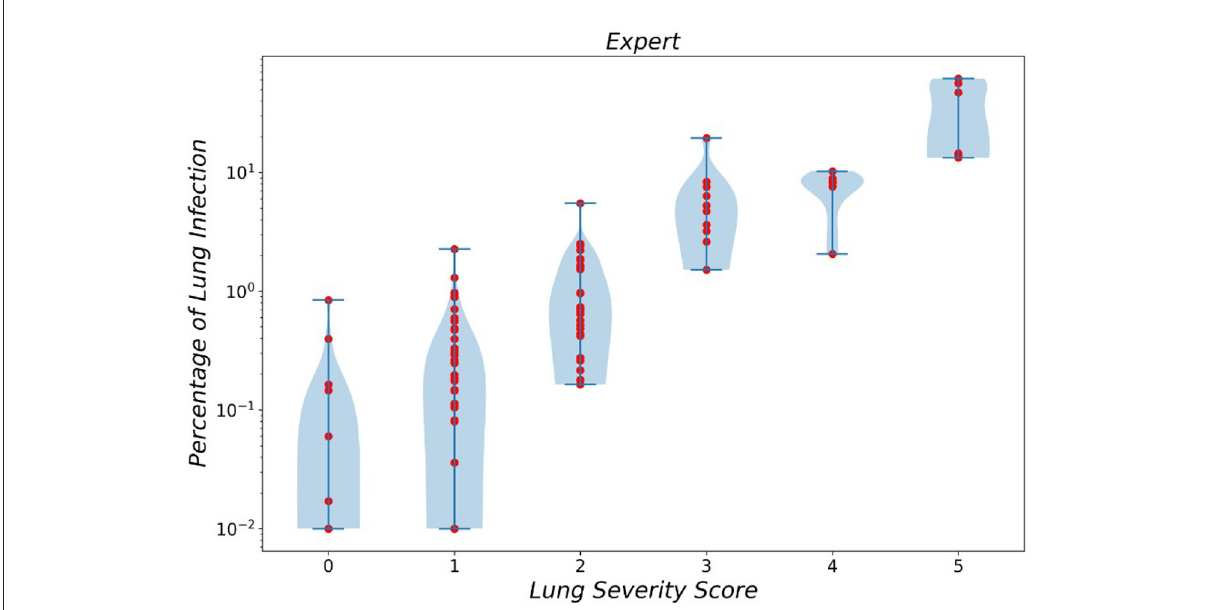
FIGURE6 Violin plot of infection severity percentage predicted by experts for 6 different classes.